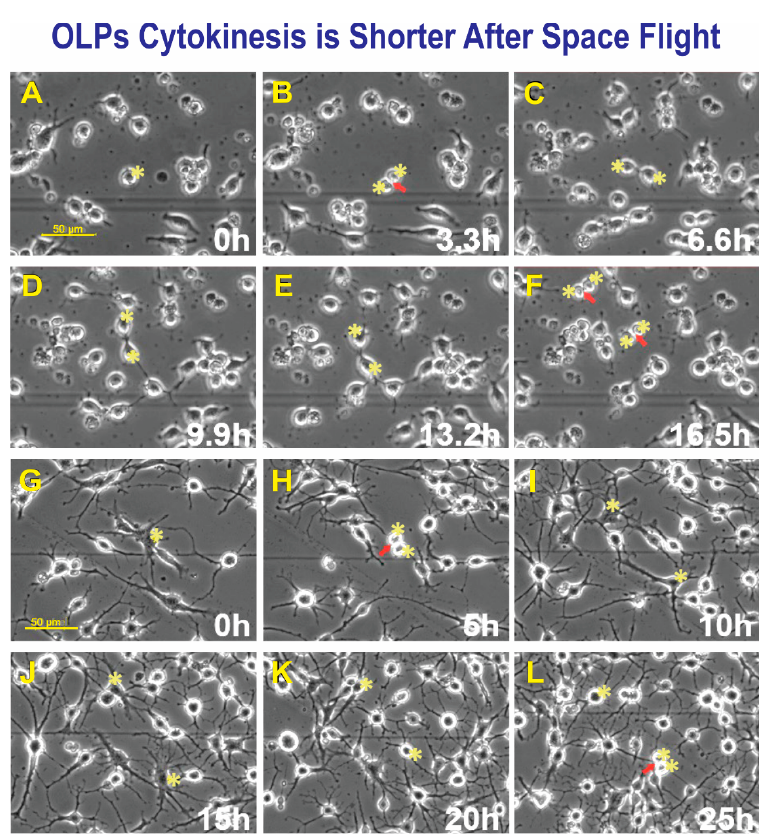
Figure 5. After seeding, SPC-OLPs were placed in the time-lapse microscope system with an incubator to control temperature and the CO 2 environment. We captured phase contrast images every 10 min to visualize the changes occurring in cells after space flight and, in particular, cytokinesis. Sequential view of SPC-Flown OLPs ( A – F ). ( A ) Shows a cell prior to dividing, 11 h after the time-lapse acquisition started. ( B ) The cell was already dividing 3.3 h later. ( C ) Cytokinesis had been completed after 3.3 h. ( D ) Daughter OLPs—both cells had formed cell processes becoming bi-polar. ( E ) After 3.3 h, both cells looked almost the same. ( F ) After 3.3 h, both cells gave rise to two daughter cells in a total time of 6.6 h. GC-OLPs ( G – L ). ( G ) Ground control cells at this time point, 16.3 h after image acquisition started, OLPs were mostly bipolar or tripolar with long cell processes. ( H ) Most cells remained bipolar, but a few had developed five or six processes. ( I ) In 6 h, a cell had divided giving rise to two daughters (arrow and asterisks). ( J ) Five hours later, these cells developed multiple and robust processes (asterisks). ( K ) The appearance of the two cells was still in the same field of view and their appearance had become simpler, they bore processes but thinner and less numerous. ( L ) One of these cells divided again 20h after it had been generated (arrow). The second cell in the top right did not divide during this